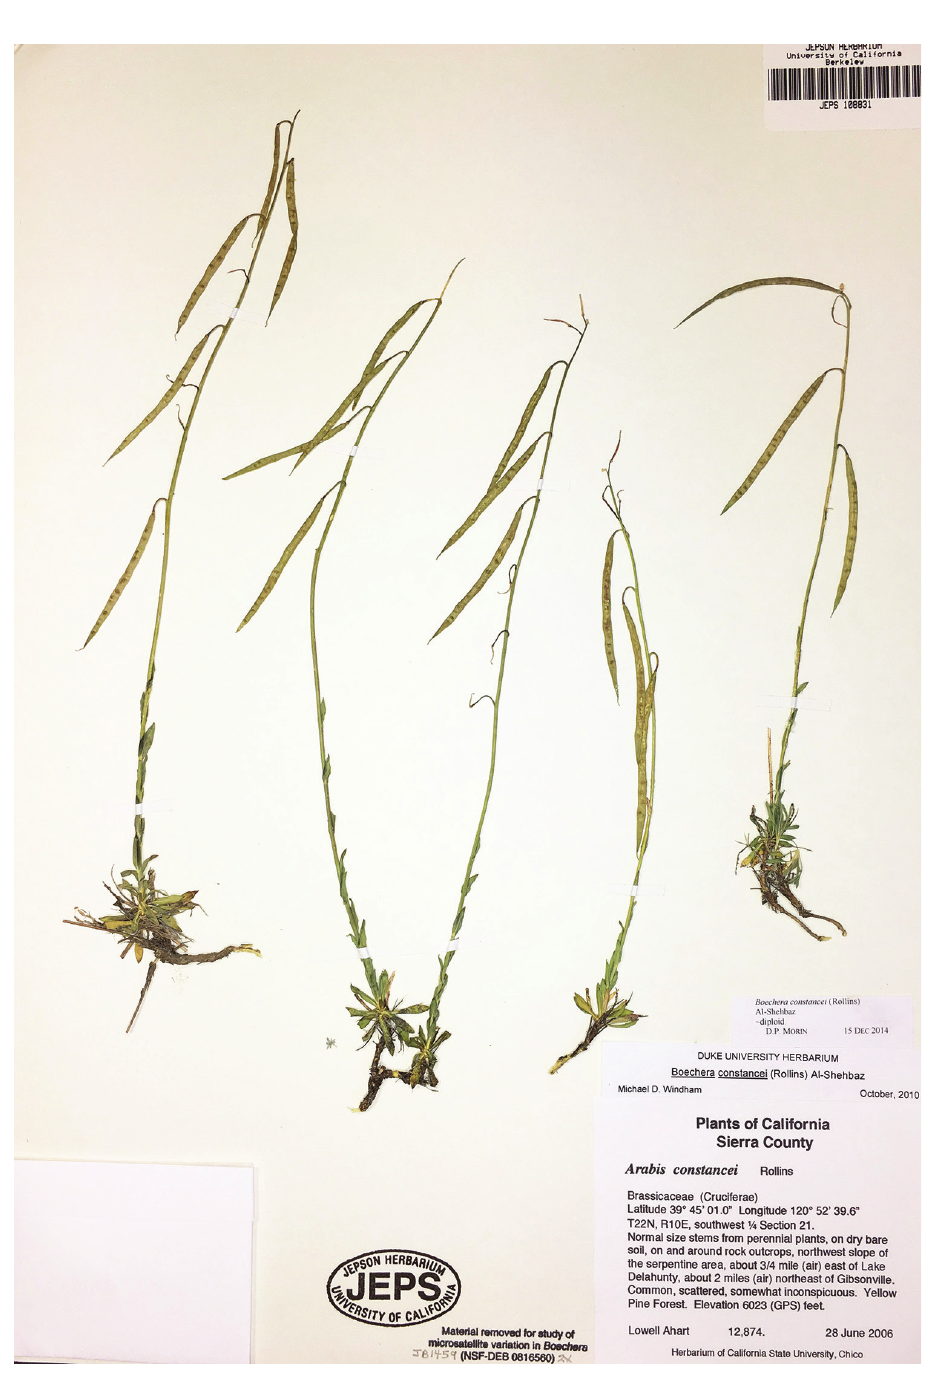
Figure 6. Boechera constancei , Ahart 12,874